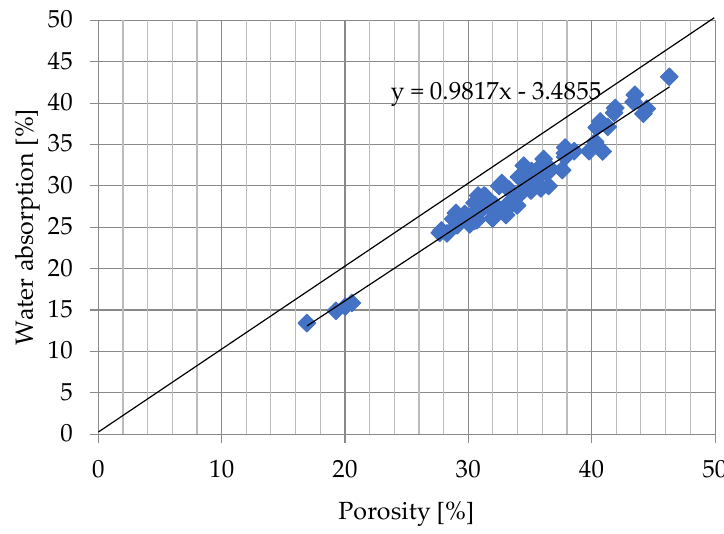
Figure 5. Water absorption after 7 days of submersion in cold water.